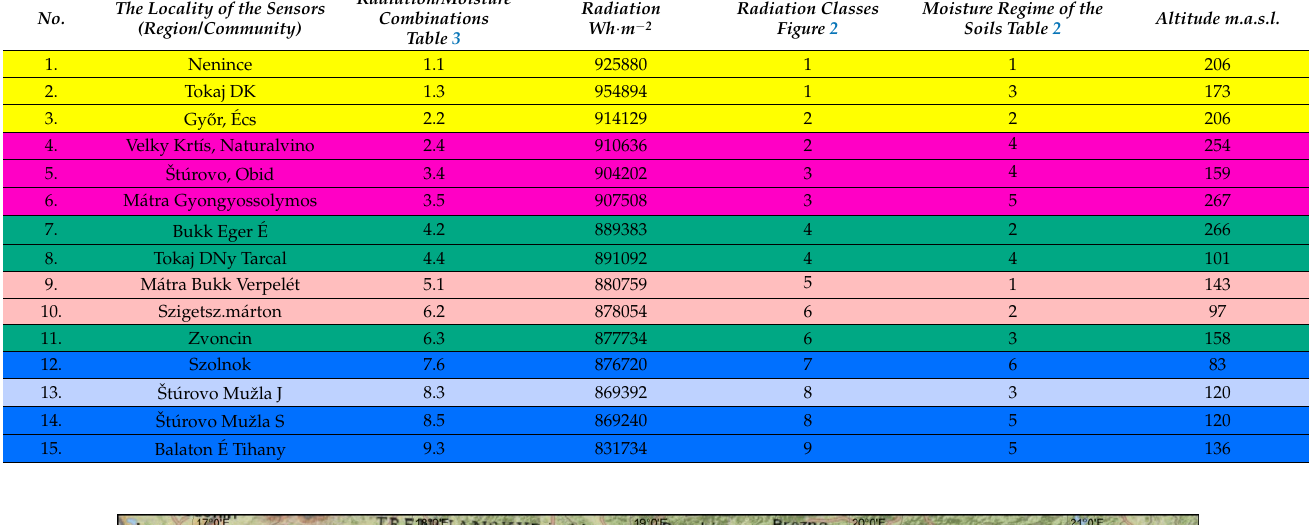
Table 4. Selected characteristics of the sensor localities (the colour distinction is the same as in Table 3).